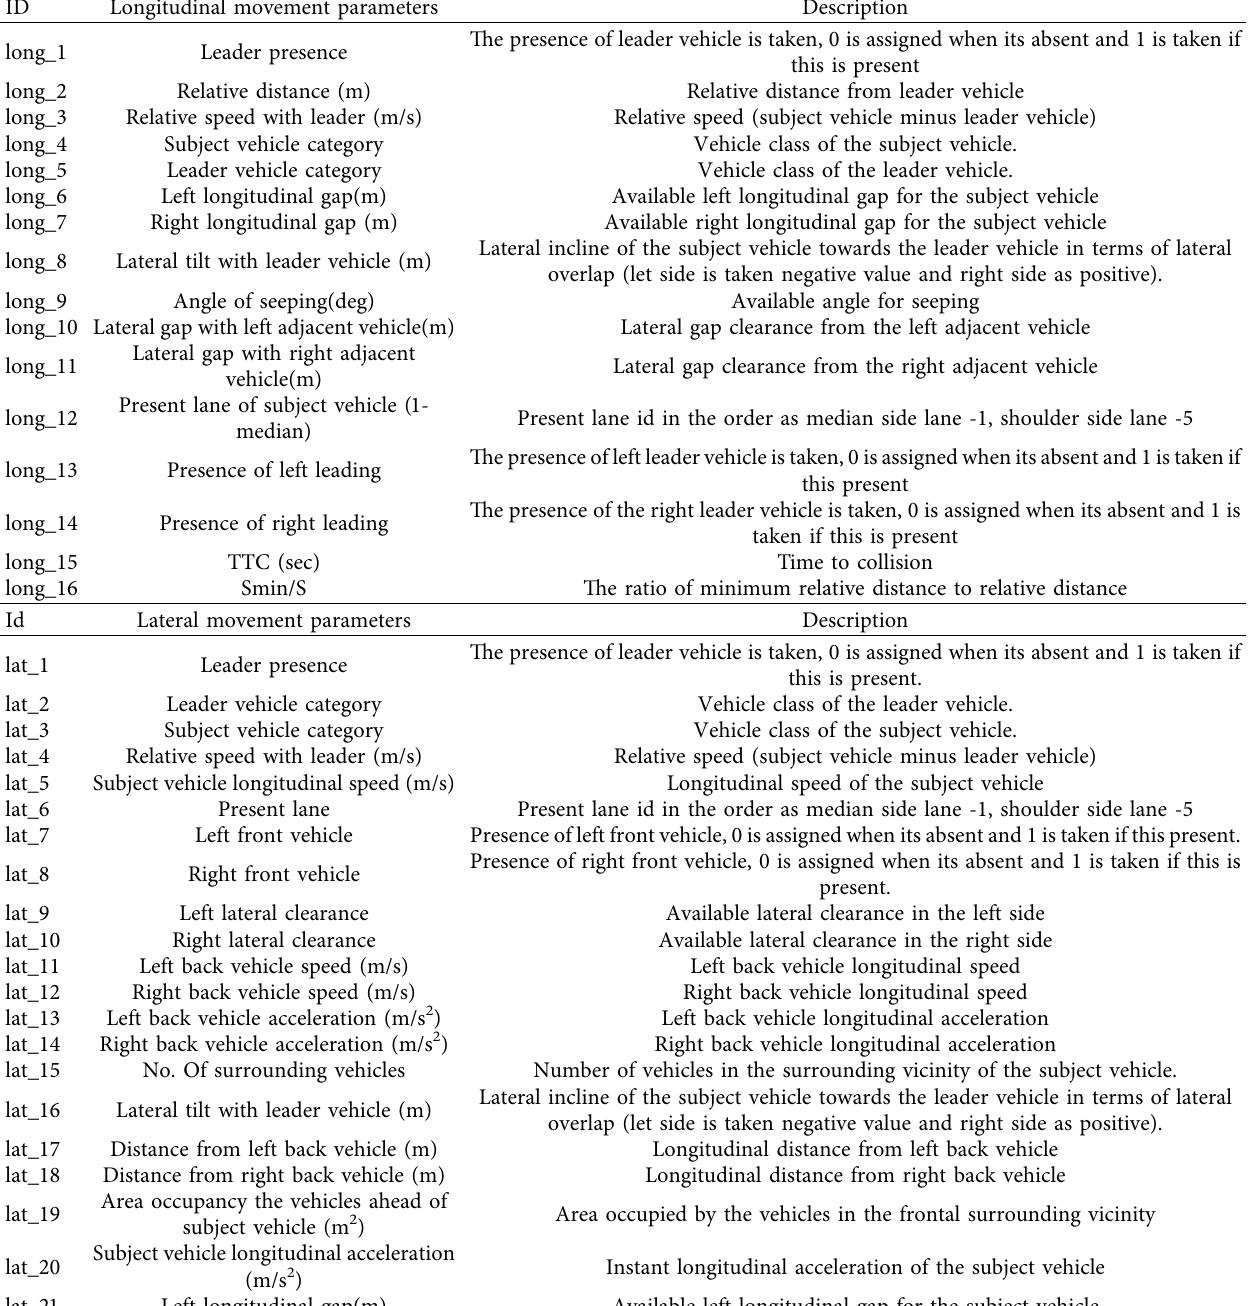
Table 2: Parameters influencing the movement of mixed